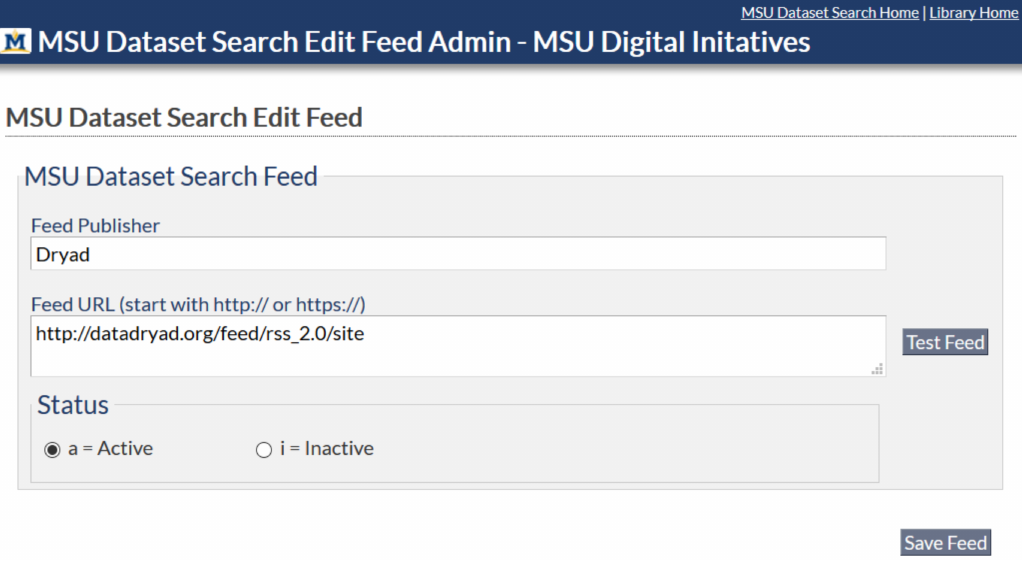
Figure 5. The Edit Feed web